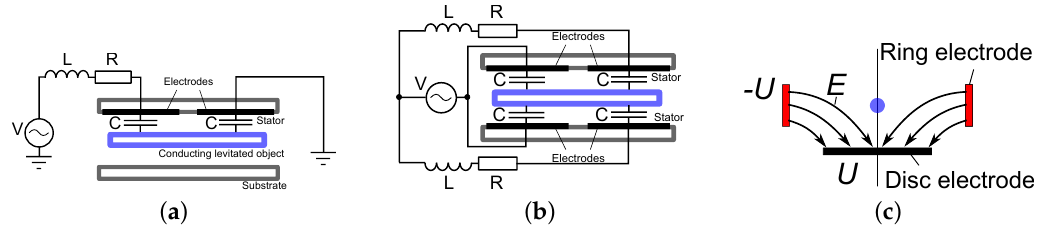
Figure 2. Electric levitation micro-actuators based on the passive levitation: ( a ) single-stator design; ( b ) dual-stator design; ( c ) levitation of a charged particle in a hyperbolic oscillating electric field E (U is the applied electric potential).